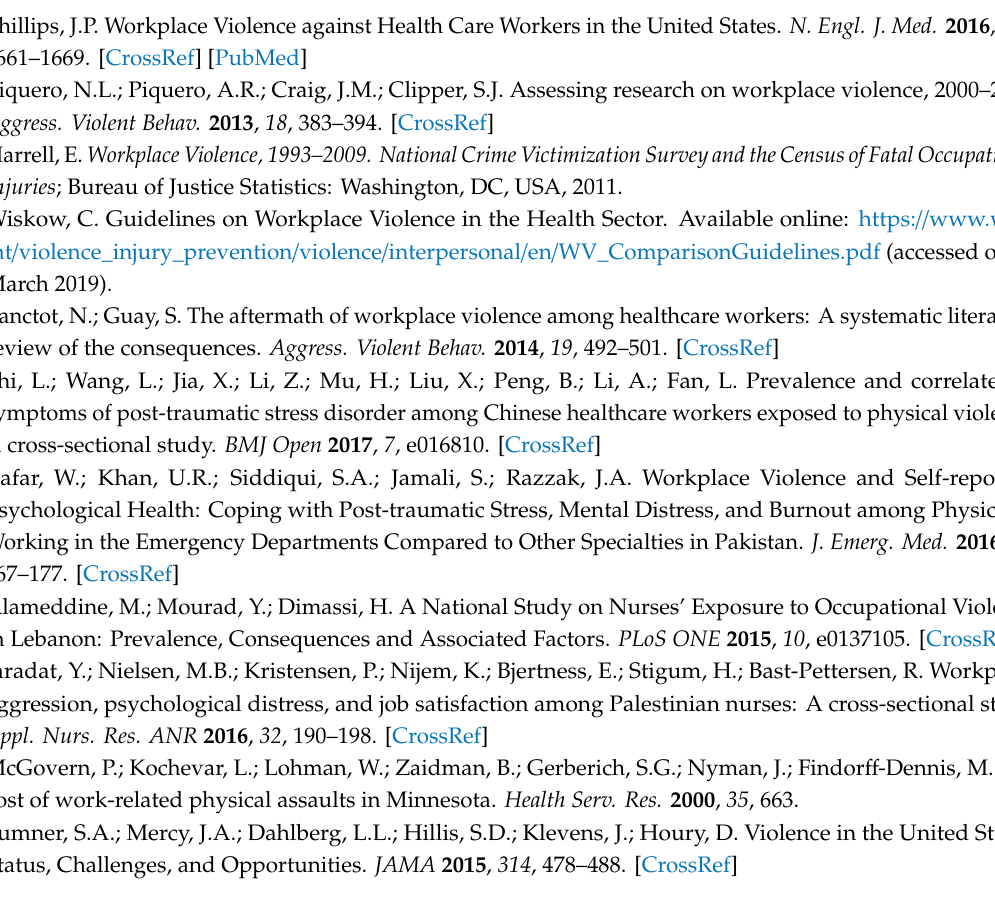
Table S1: PRISMA-2009-checklist; Table S2: Database searches results; Table S3: Methodological quality assessment of the eligible